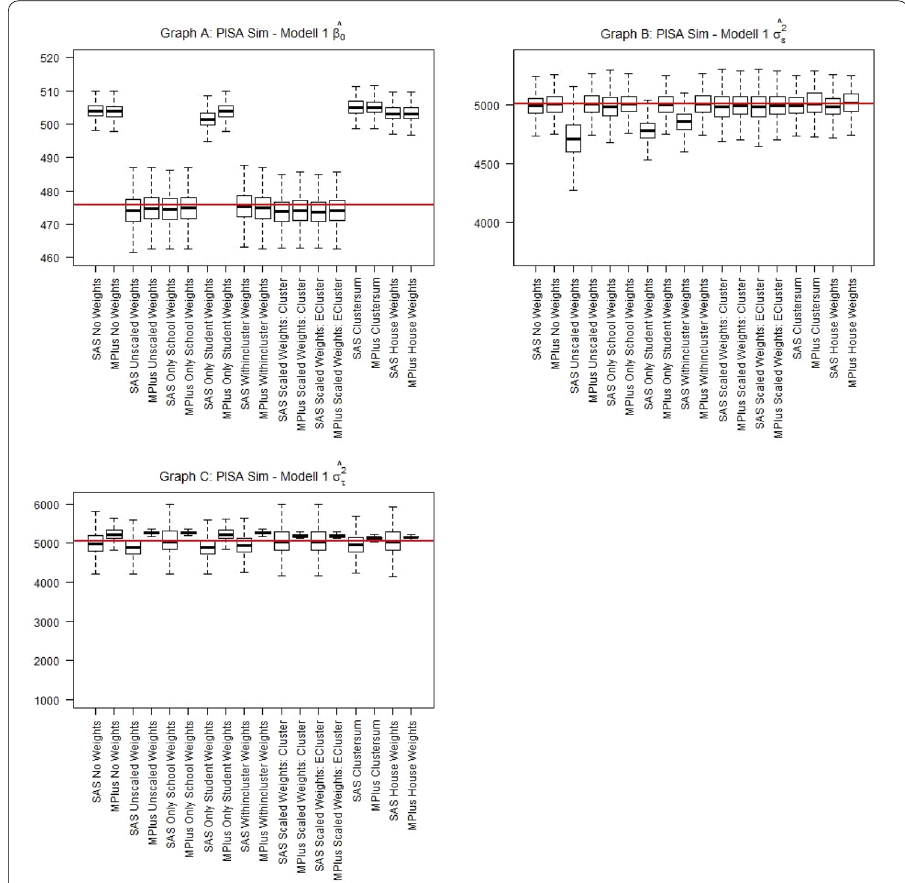
Fig. 1 Simulation outcomes for data mirroring the German PISA population. Model 1 is declared as y ij = β 0 + τ i + ε ij , Model 2 as y ij = β 0 + β 1 ∗ x ij + τ i + ε ij and Model 3 as y ij = β 0 + β 1 ∗ x ij + β 2 ∗ x i + τ i + ε ij . The median, the 25% and 75% quartiles, minimum and maximum for each model estimator are presented in boxplots. No outliers are displayed. The true population values for each estimate are marked as red line.